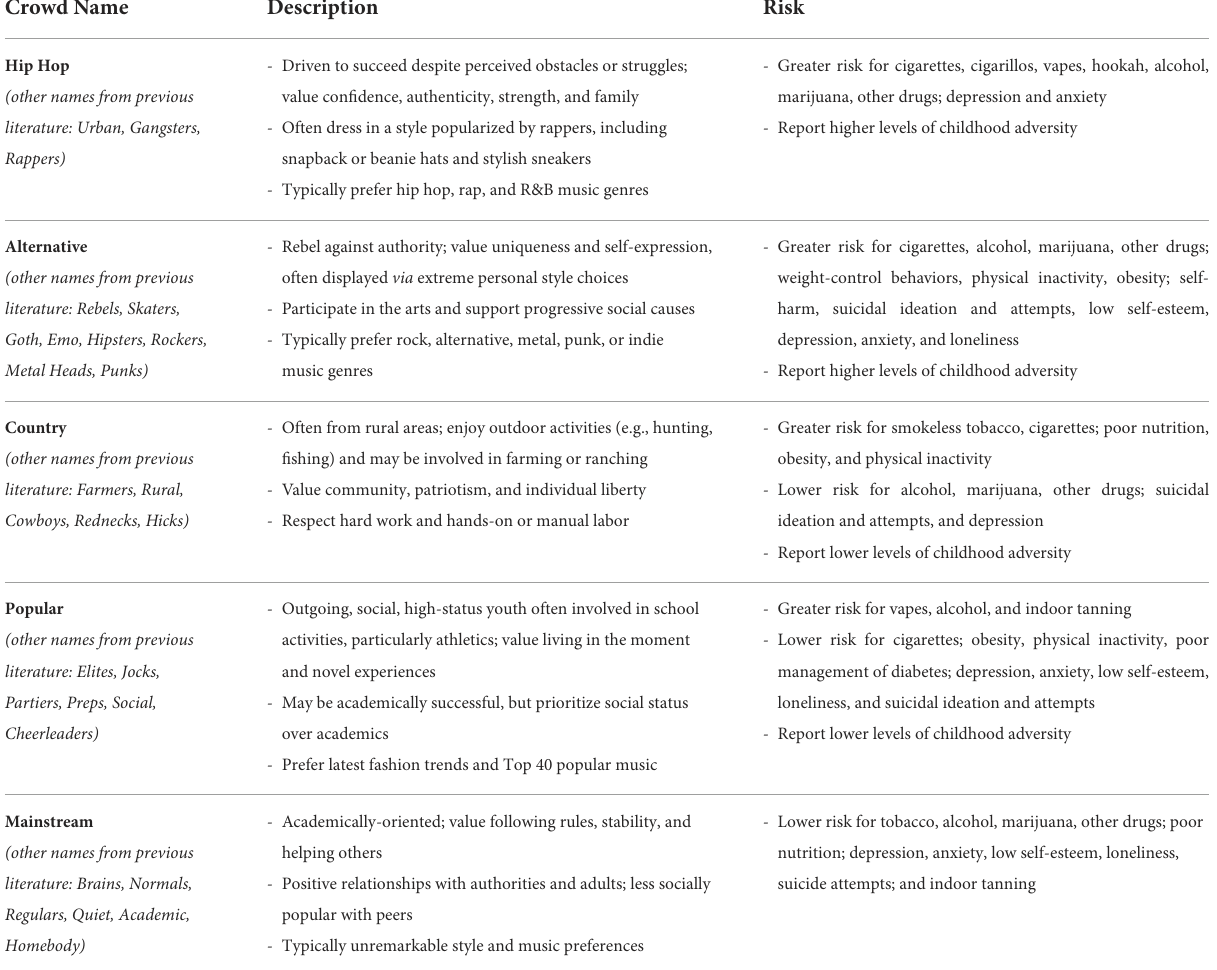
TABLE 1 Common teen peer crowds (11, 18, 20,